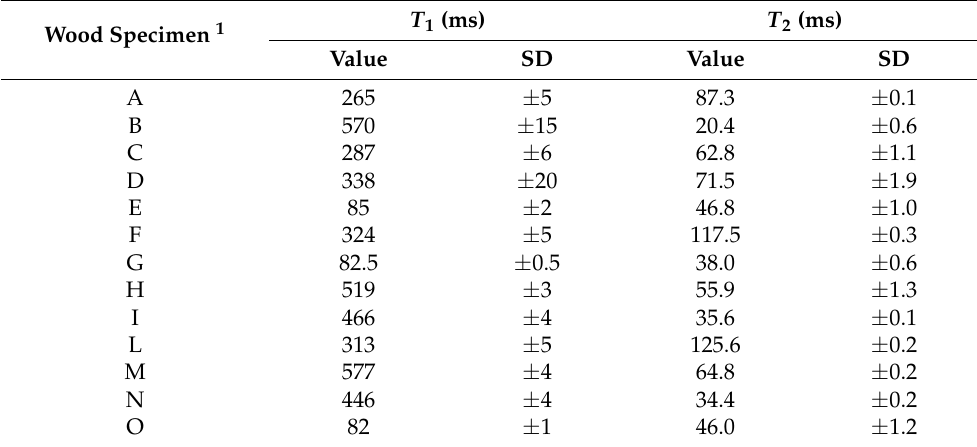
Figure 4. Multiparametric transversal-view MRI obtained at 3T clinical scanning of a sample com- posed of sixteen different water-imbibed wood species. ( a ) T 2 -weighted image ( T 2 -w) obtained with a spin-echo-based acquisition sequence with TE = 16 ms, TR = 1500 ms, NS = 1. The in-plane resolution was 0.3 × 0.3 mm 2 with a slice thickness of 5 mm; ( b ) T 2 *-weighted image ( T 2 *-w) obtained using a gradient echo-based acquisition sequence with TE = 4 ms, TR = 1000 ms, NS = 1. The in-plane resolution was 0.25 × 0.25 mm 2 with a slice thickness of 5 mm; ( c ) T 1 -weighted image ( T 1 -w) obtained using an inversion recovery-based acquisition sequence with TE = 20 ms, inversion time IR = 1800 ms and TR = 2000 ms. The in-plane resolution was 0.25 × 0.25 mm 2 with a slice thickness of 5 mm; ( d – f ) T 2 , T 2 *, and proton density (PD) maps are displayed, respectively. The colors of the right bars are proportional to T 2 , T 2 *, and proton density, respectively. In multiparametric maps, each voxel provides the parameter value, whereas, in the parameter-weighted image, each voxel provides signal attenuation due to relaxation at a fixed acquisition parameter TE or IR. Table 4. T 1 and T 2 of 100% soaked wood